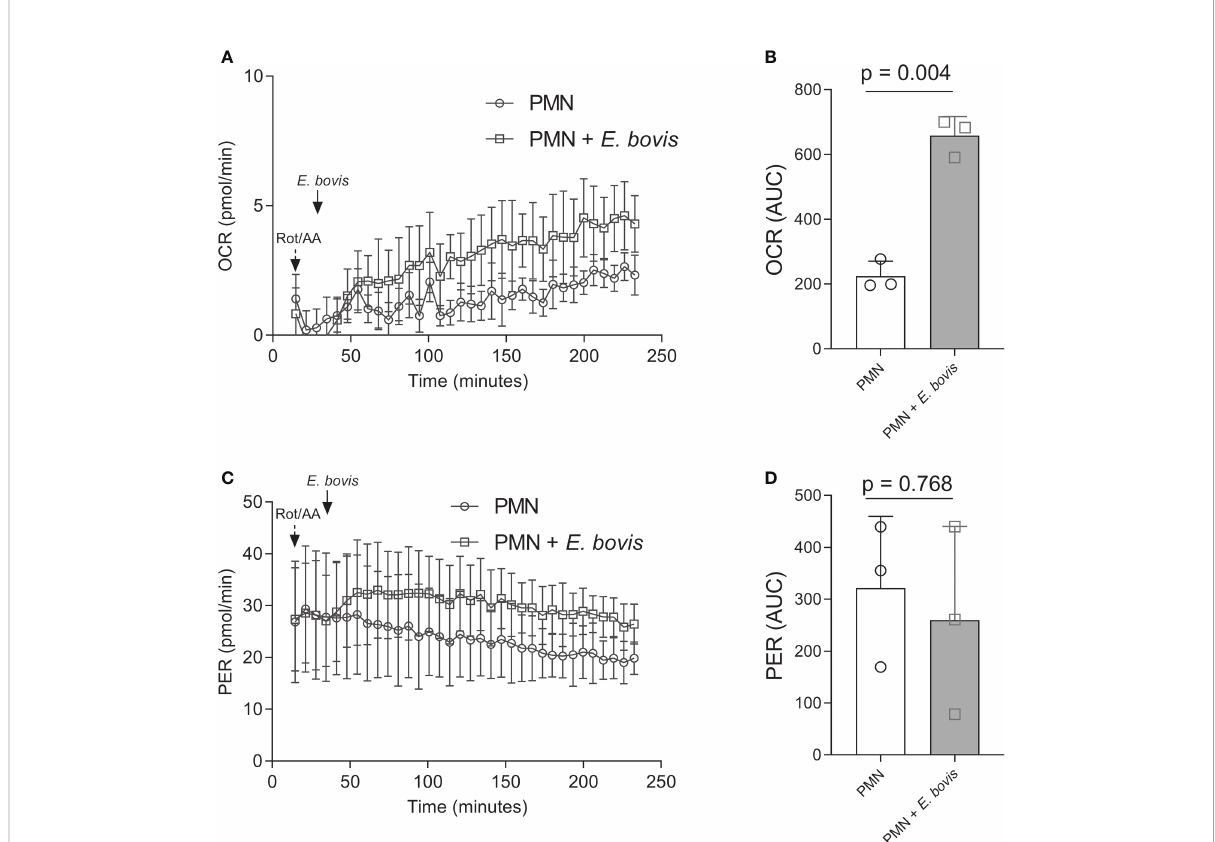
FIGURE 1 Oxygen consumption and extracellular acidi fi cation rates in E. bovis sporozoite-exposed bovine PMN. Oxygen consumption rate (OCR) and extracellular acidi fi cation rate (ECAR) expressed as proton ef fl ux rate (PER) of bovine PMNs exposed to E. bovis sporozoites were measured by an extracellular fl ux analyzer (Seahorse Bioscience). A total of 100,000 PMNs were plated in eight-well XFp Agilent plates, and rotenone/ antimycin A and E. bovis sporozoites were injected sequentially. OCR (A) and PER (C) were measured during 240 min, and the corresponding area under the curve of each registry (B, D) was calculated for each experimental condition to quantify the activation of bovine PMN. All data are shown as mean±SEM; p values were calculated by a paired two-tailed t-test analysis